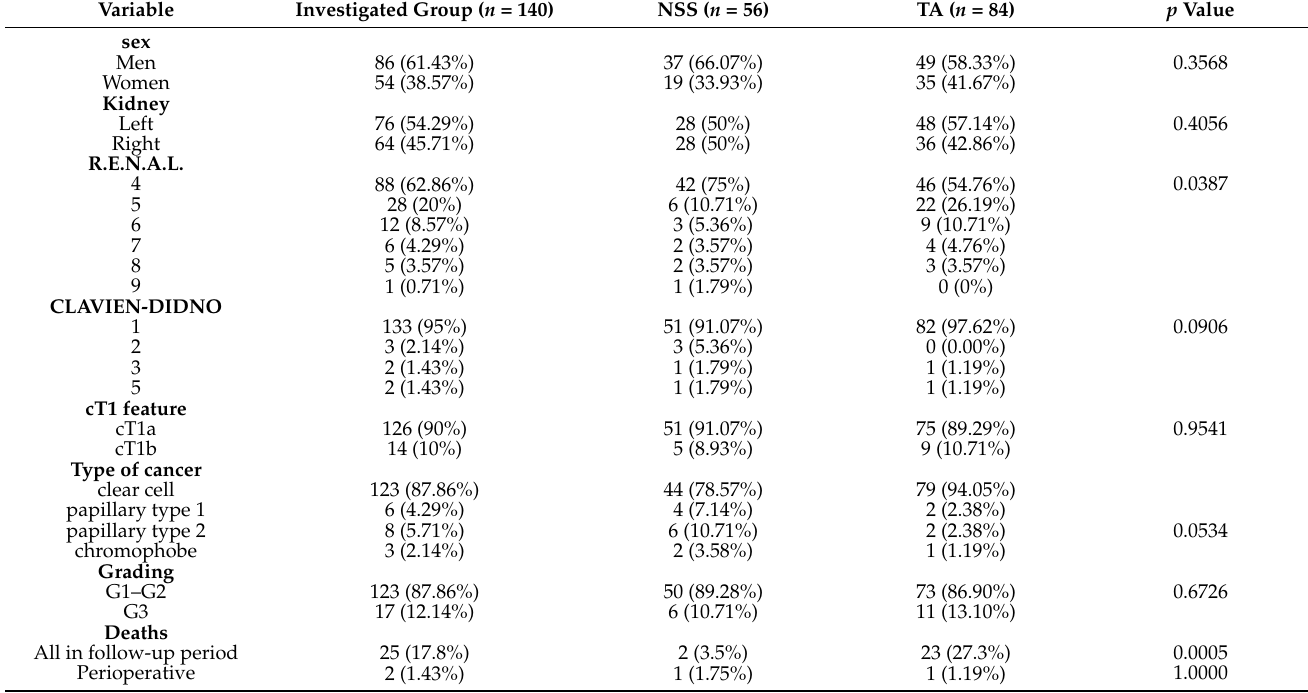
Table 1. Comparison of distribution of nominal variables in the whole group and between NSS- treated and TA-treated